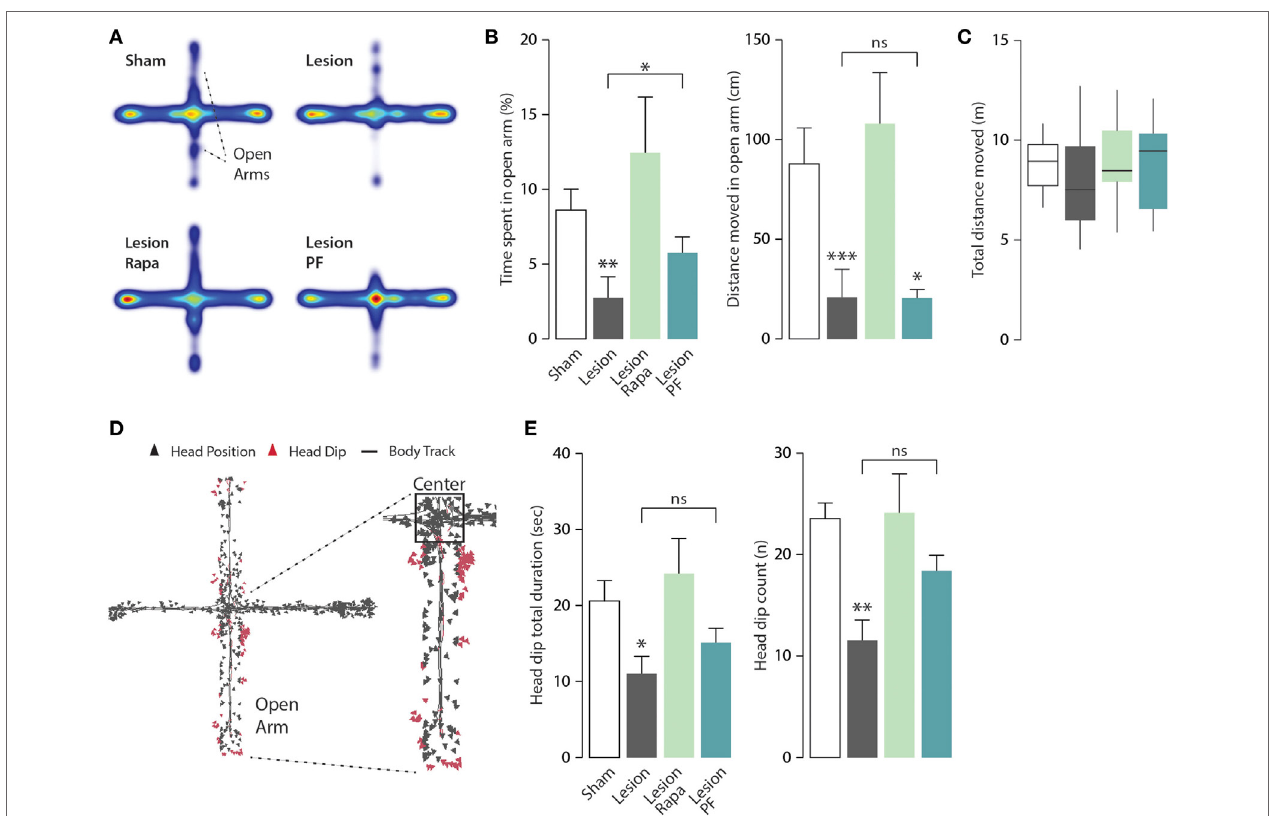
FigUre 4 | Rapamycin abolishes anxiety-like behavior in a mouse model of Parkinson’s disease. Elevated plus maze (EPM) test performance in Sham mice treated with vehicle ( n = 12), and Lesion mice treated with vehicle ( n = 12), rapamycin (Lesion Rapa, n = 12), or PF-4708671 (Lesion PF, n = 12). (a) Group average heat map locations where range of colors was calculated comparing location frequencies over all subjects. (B) Time spent in the EPM open arm expressed as percent of total time (left panel) and total distance moved (cm) (right panel) during the 5-min test. ** p = 0.005, * p = 0.03 vs. Sham for time, and *** p = 0.0005, * p = 0.048 vs. Sham for distance (Kruskal–Wallis test followed by Dunn’s post hoc comparison). (c) Tukey whiskers plots with the median, 10th, 25th, 70th, and 90th percentiles showing total distance (m) covered in the EPM. One-way ANOVA showed no differences between groups. Groups and treatments are as indicated in (B). (D) Head dip analysis carried out by tracking nose-point position, as an additional marker of anxiety. Triangles indicate the head position during the test with head dip events in red. (e) Total duration (s) of head dips (left panel) and number of events (right panel). Data are presented as mean ± SEM. * p = 0.03 and ** p = 0.002 vs. Sham group (one-way ANOVA followed by Fisher’s post hoc